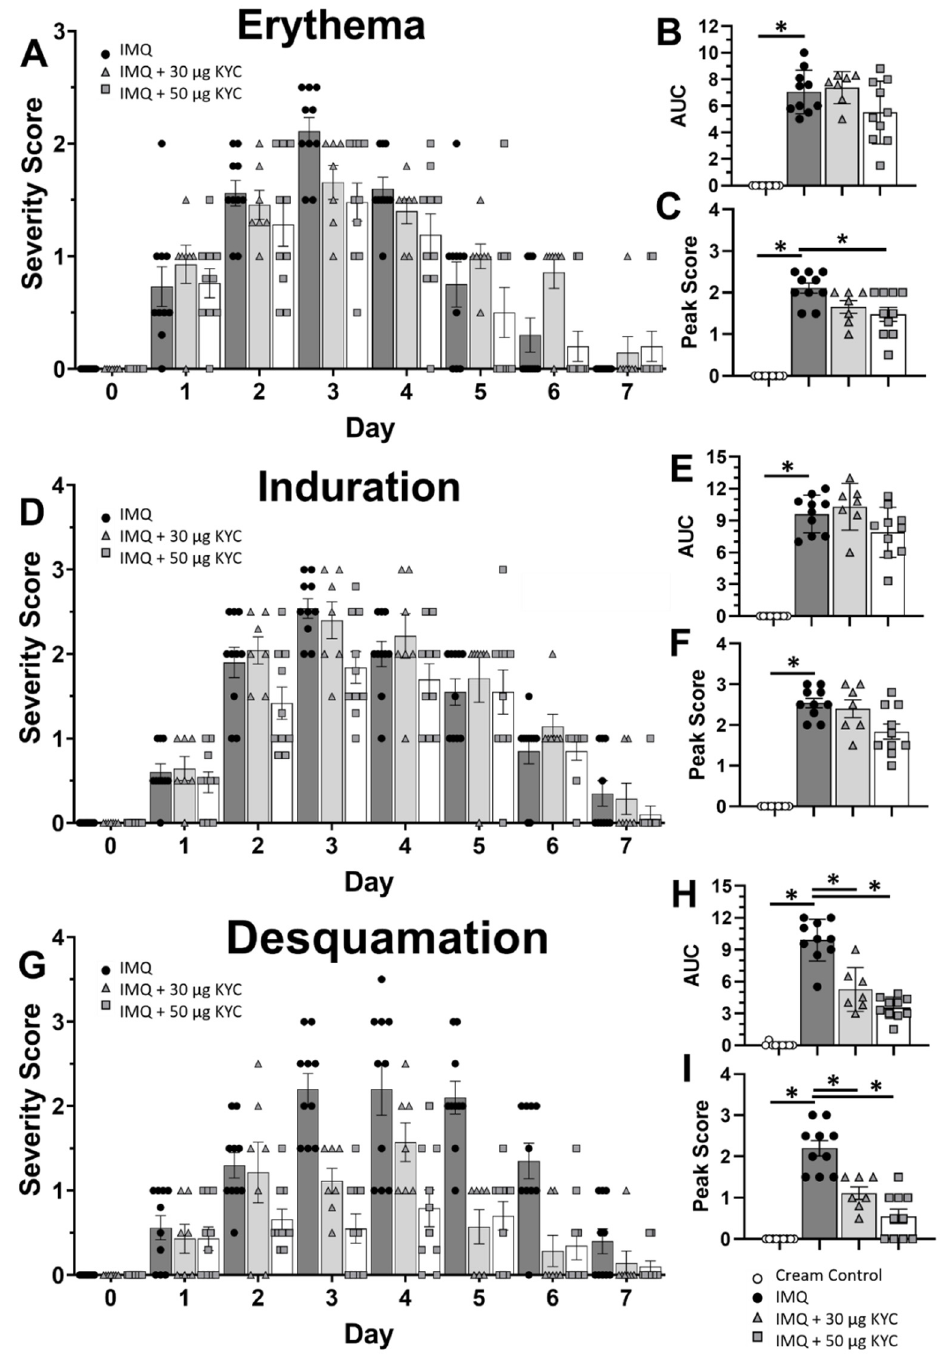
Figure 5. Topical application of KYC cream differentially attenuates parameters of skin inflammation. Cumulative PASI scores from Figure 4B were parsed into individual skin parameters: erythema ( A – C ), induration ( D – F ), and desquamation ( G – I ). ( A , D , G ) Daily PASI parameter scores are shown. ( B , E , H ) AUC from the daily scores was calculated per parameter. ( C , F , I ) Peak skin parameter incidence (day 3) is shown. Cream control = white circles; IMQ psoriasis = black circles; IMQ + 30 mg/kg KYC = gray triangles; IMQ + 50 mg/kg KYC = gray squares. Each data point represents one mouse. Data shown are the mean and SEM ( A – I ). Data include two replicate experiments containing 4–5 mice per group ( A – I ). * p ≤ 0.05.